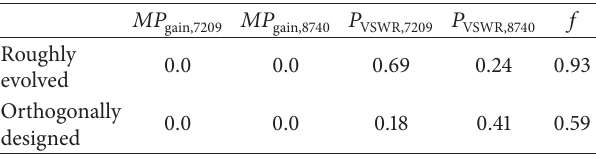
Table 8: Comparison of objective values between the roughly evolved antenna and the orthogonally designed